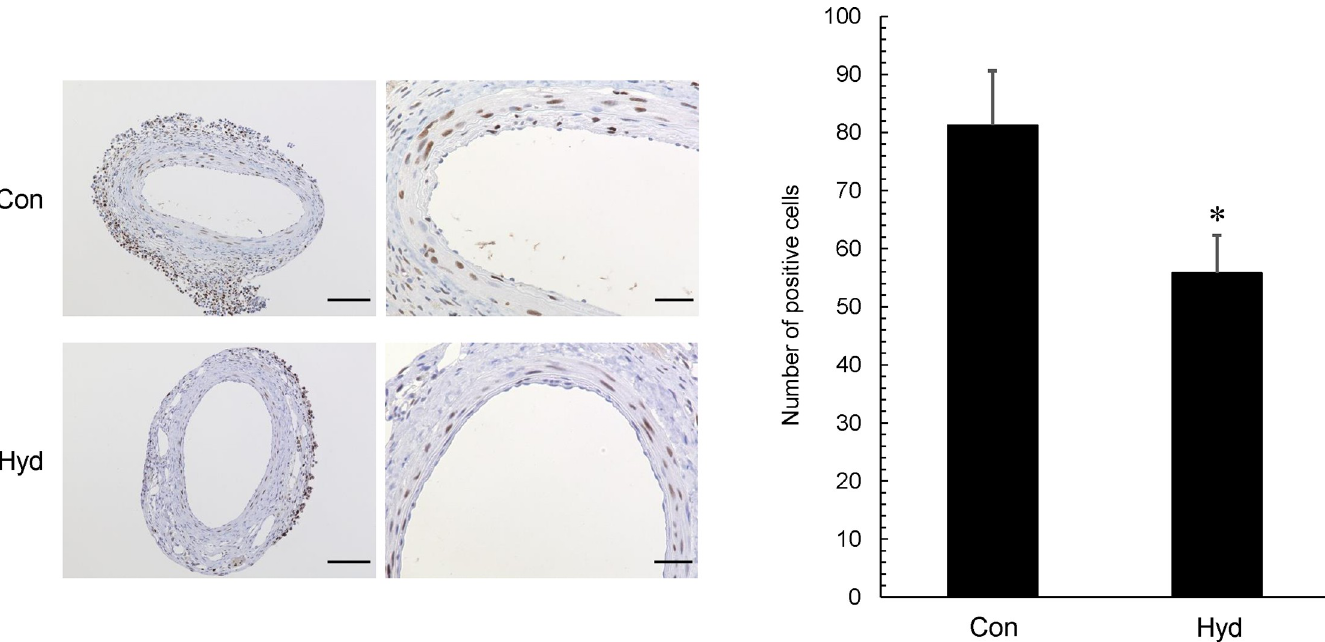
Fig 3. Effect of hydrogen gas inhalation on cell proliferation in injured femoral artery after cuff placement. Representative photos and quantitative analysis of injured femoral artery in cross-sections after immunohistochemical staining (for PCNA) are shown. Original magnification × 200 (scale bar: 100 μ m) and × 600 (scale bar: 30 μ m). In quantitative analysis, data represent the number of PCNA-positive cells in neointima and vascular media, and values are mean ± SEM (n = 16 for each group). � p < 0.05 vs. Con.